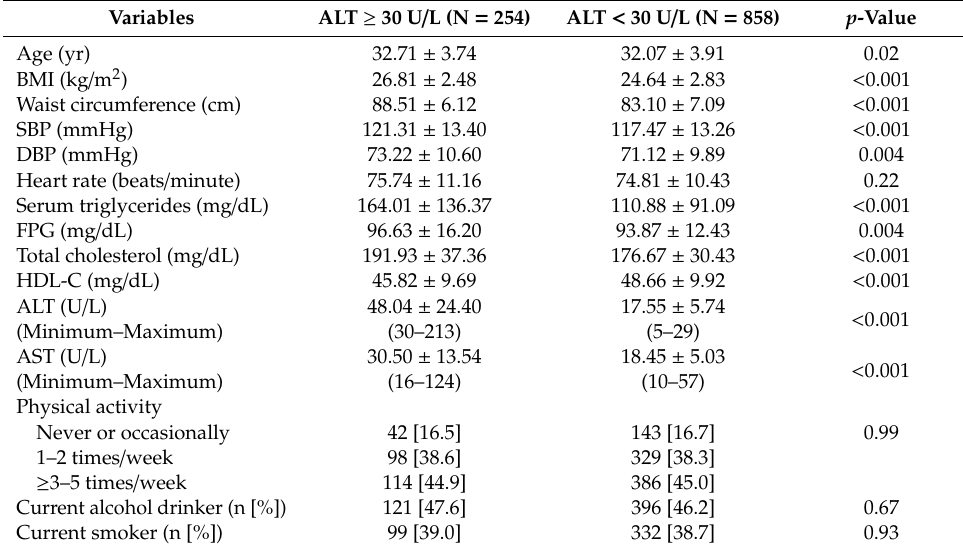
Table 1. Clinical characteristics of the study